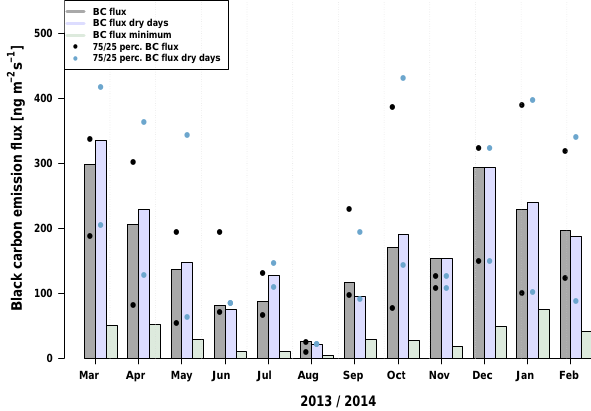
Figure 11. Seasonal cycle of the estimated BC emission flux based on the mean diurnal cycle per month using the data of all days ( F BC ) (grey) and only dry days ( F BCdrydays ) (blue) and with only using the estimated flux in the morning hours and for other hours zero flux is used ( F BCmin )